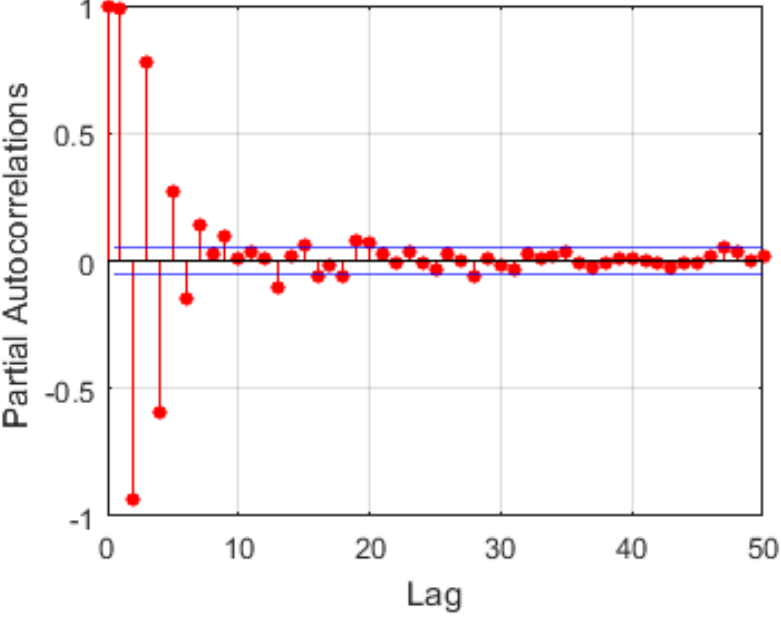
Figure 9. Partial autocorrelation of